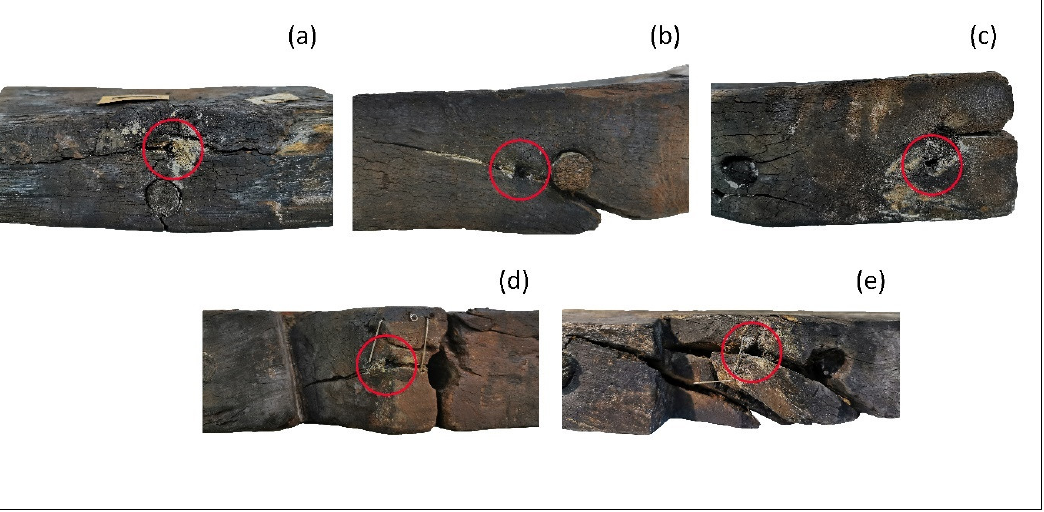
Figure 9. Photographs taken to illustrate the areas where pH values were measured for ( a ) E8, ( b ) E9, ( c ) E11, ( d ) E13, and ( e ) E17. Table 3. Average pH values determined for the wood samples E8, E9, E11, E13, and E17. Sample